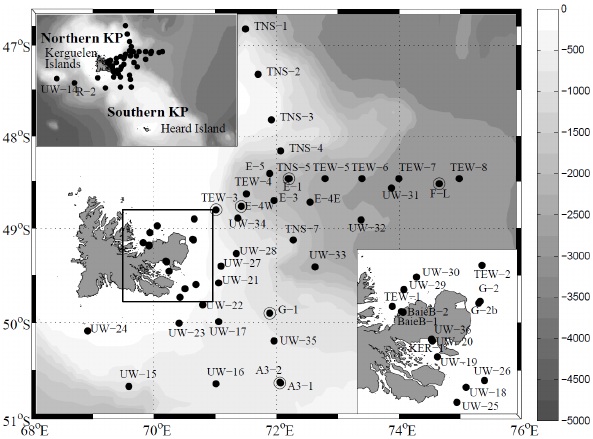
Figure 1. Location of stations investigated for Ra analysis. Solid circles represent surface seawater samples. Circles show the loca- tions where vertical profiles were made. KP is the abbreviation for Kerguelen Plateau. Gray shading represents depth in